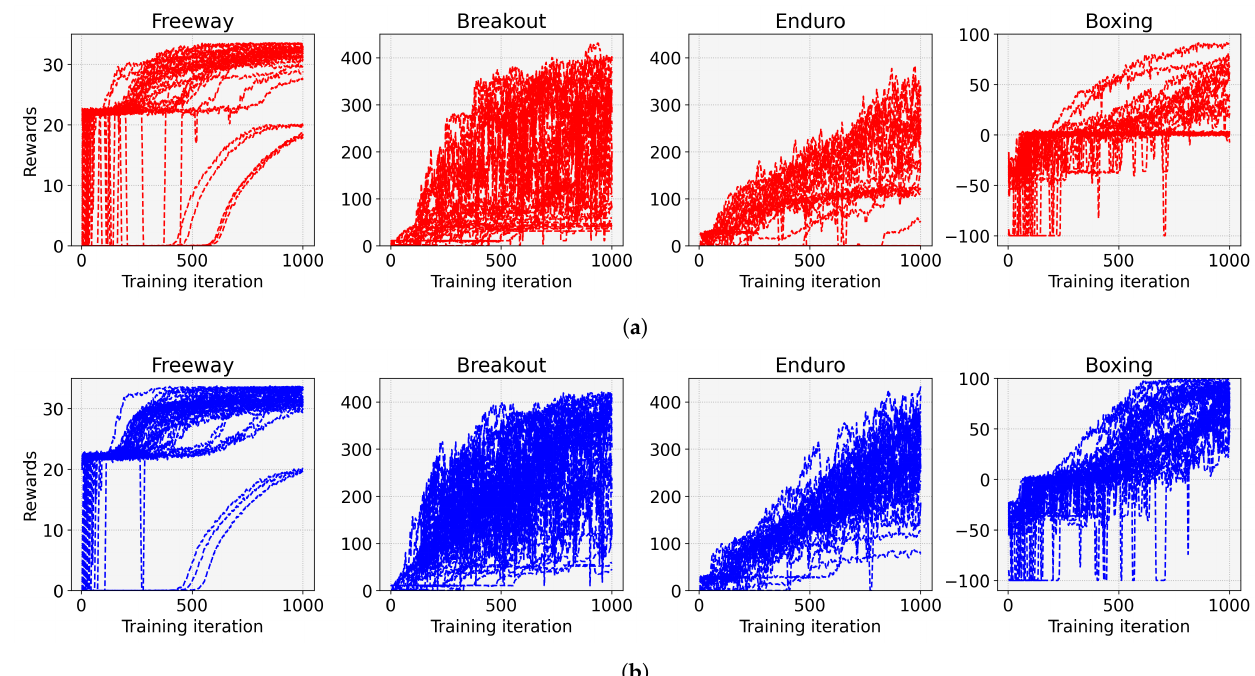
Figure 8. Learning curves for 30 individual experiments of ( a ) the conventional A2C and ( b ) the proposed entropy-aware model initialization-based A2C for four tasks. ( a ) default; ( b ) proposed. Table 3. Statistical results for the experimentation of the entropy-aware model initialization-based PPO and the conventional PPO.